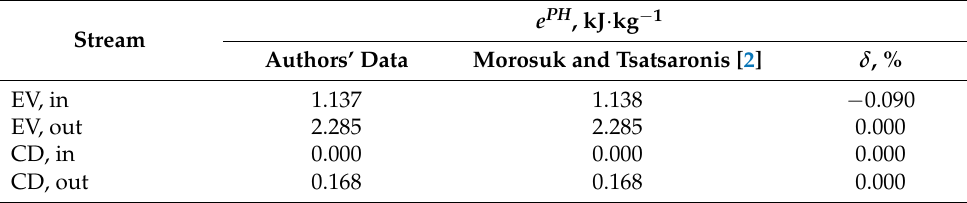
Table 1. Values of specific physical exergy of the secondary working fluids (air).